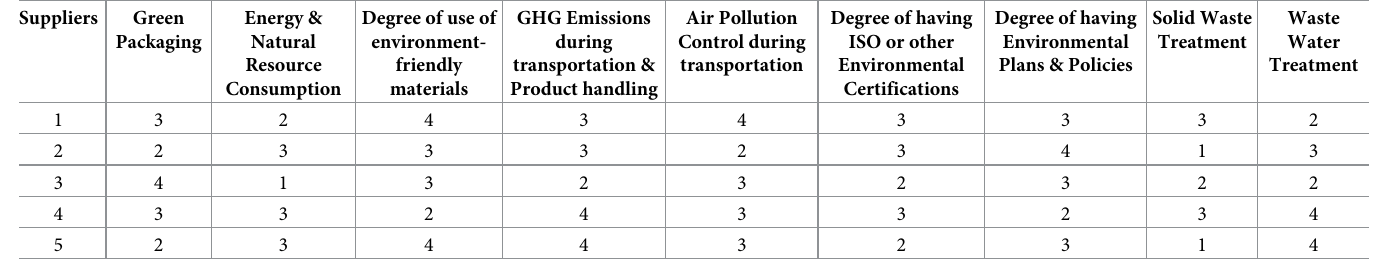
Table 2. Scores of green parameters.